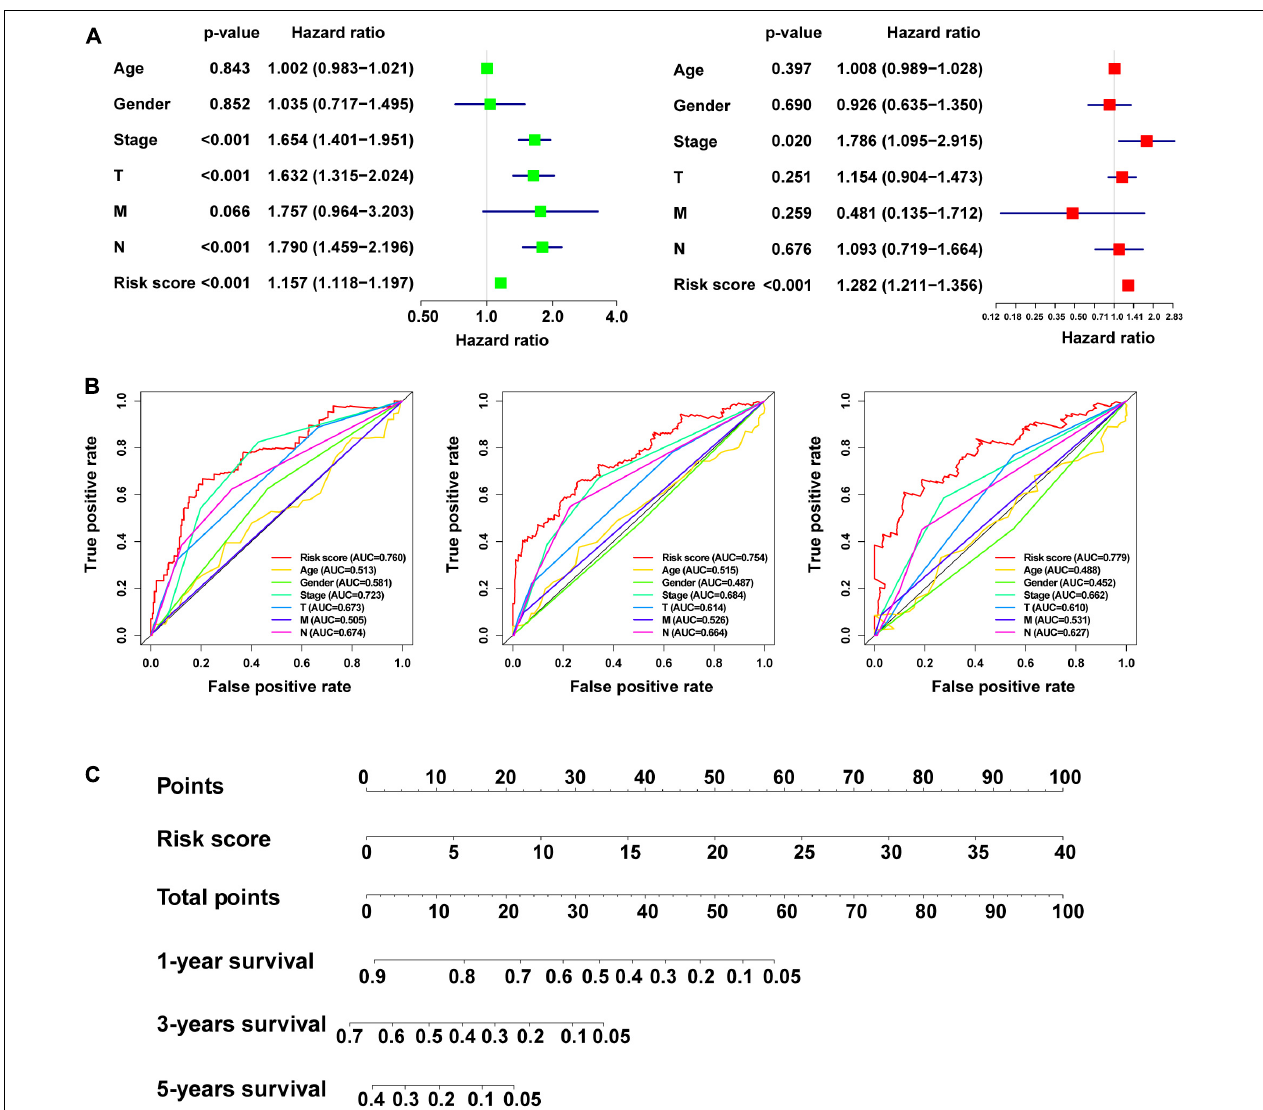
FIGURE 5 | Verificationof the risk model and construction of the nomogram. (A) Univariate and multivariate Cox regression analysis of the prognostic value of risk scores and clinical features. (B) Determination of the area under the ROC curve (AUC) of the risk score and clinical characteristics based on the ROC curve. (C) Construction of the nomogram based on the risk